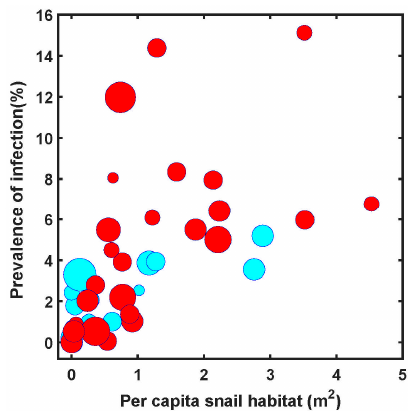
Figure 3. The relationship between prevalence of schistosomiasis infection and snail habitat for 44 endemic counties in Sichuan based on 2008 data, showing a significant correlation (R 2 = 0.371, p < 0.01). The 44 endemic counties included 18 which achieved transmission control ( cyan ) and 26 with ongoing transmission ( red ) in 2008. The sizes of circles indicate relative magnitude of per capita GDP by county.